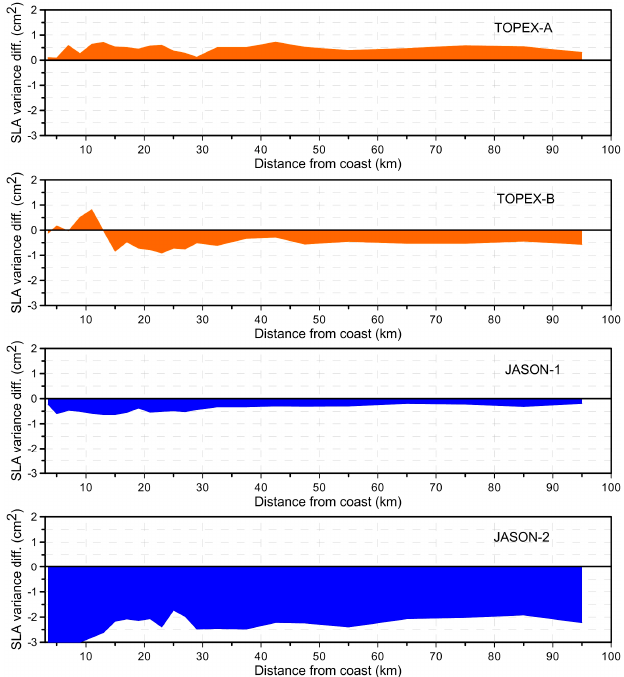
Figure 12. SLA variance differences (cm 2 ) function of distance from the coast between Sea State Bias Non-Parametric CLS and Sea State Bias Parametric BM4 for TOPEX (orange): TOPEX-A cycles 1 to 235 and TOPEX-B cycles 236 to 264; and Sea State Bias Tran and Non-Parametric CLS (blue): Jason-1 cycles 1 to 259 and Jason-2 cycles 1 to 280.